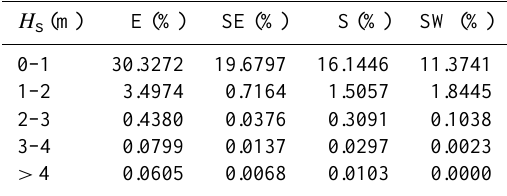
Table 2. Wave directions affecting the different ports. #